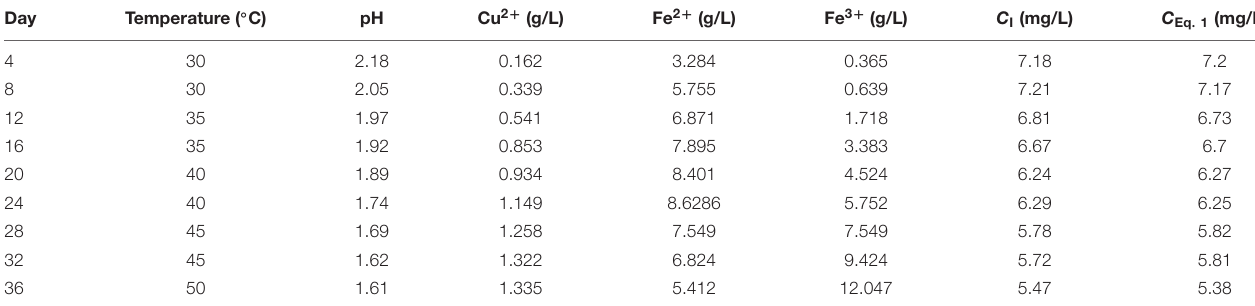
TABLE 4 | Results of verification tests ( C I is the measurement value and C Eq . 1 is the value predicted by Eq.